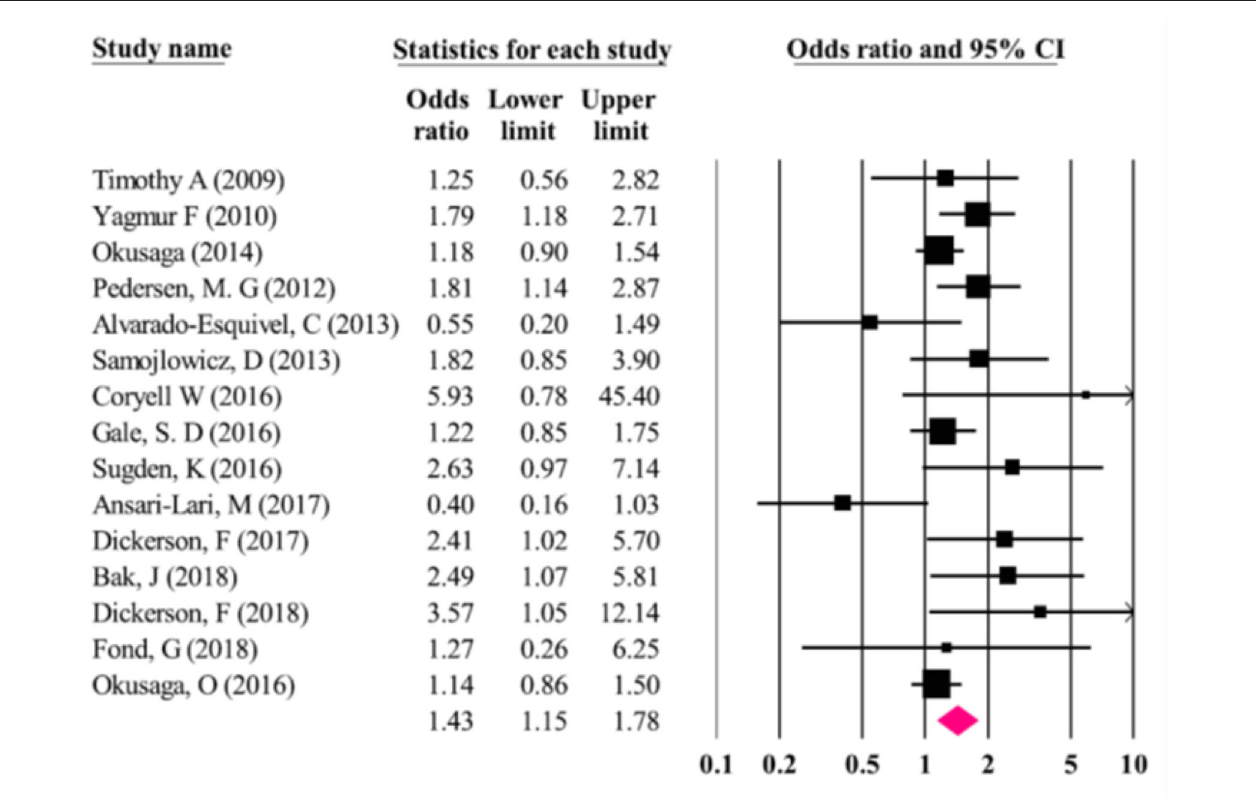
FIGURE 3 | Results (odds ratios and 95% confidence intervals) from the individual studies and the meta-analysis by Soleymani et al. (98). The first study from the Postolache group, by Timothy Arling is wrongly identified as Timothy et al. instead of Arling et al. (74). Furthermore, studies that have identified associations between serointensity (but not seropositivity), such as Arling et al. ( 74) and Okusaga et al. (95) appear as carrying no significant association [Modified and reprinted with permission from ( 98); Copyright (2020); with permission from Springer Nature; License link: